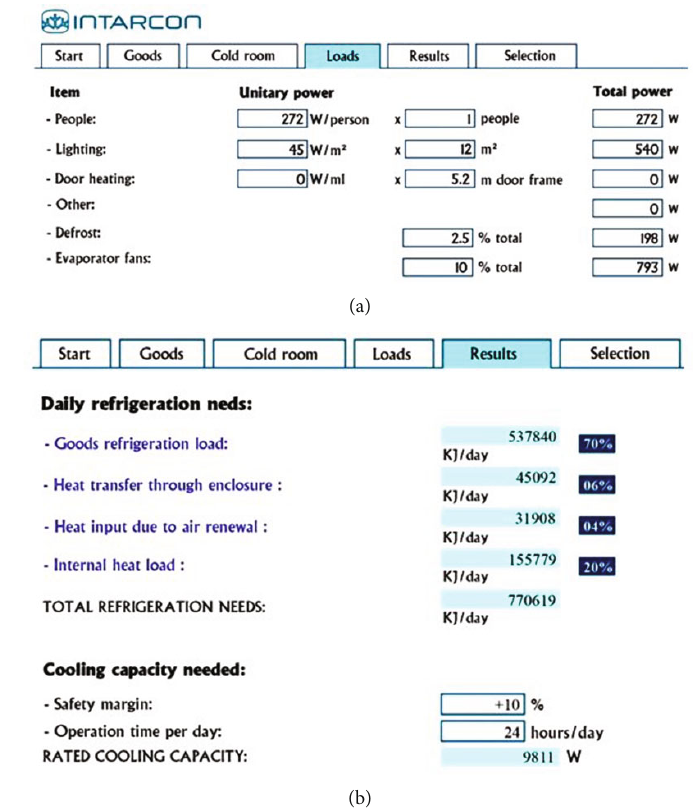
Figure 9: Details on (a) loads and (b) daily refrigeration needs of considered loads (results from INTARCON outputs).